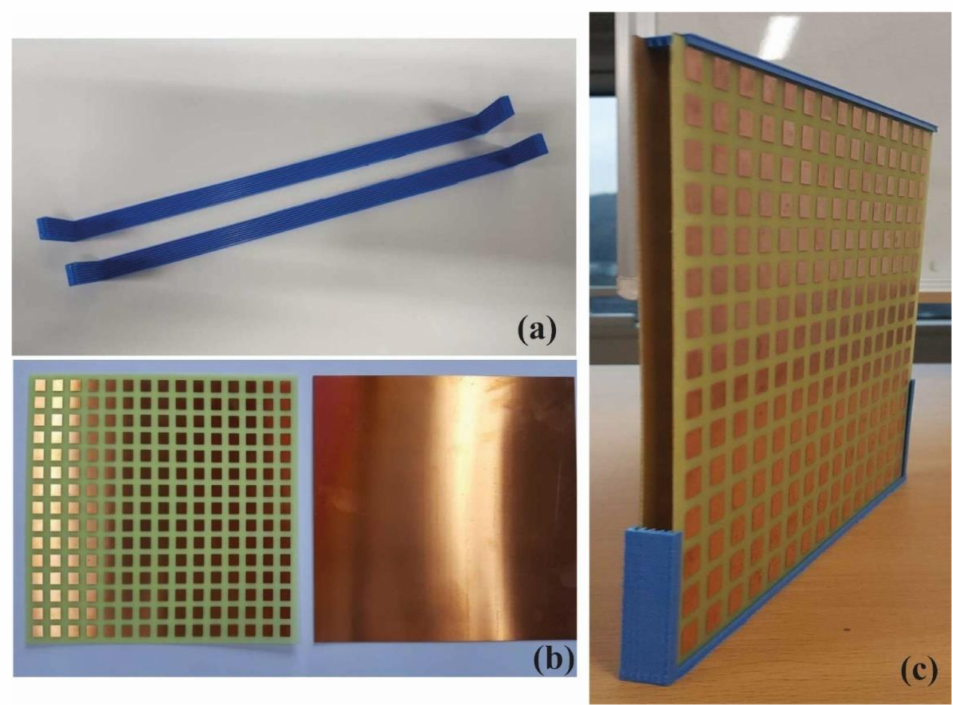
Figure 12. Pictures of the 3D-printed frame for the fixed air thickness. ( a ) Fabricated 3D PLA frame. ( b ) The fabricated absorber. ( c ) 3D PLA frame with an absorber printing (Reproduced with permission from Reference [137], copyright 2018, Hindawi